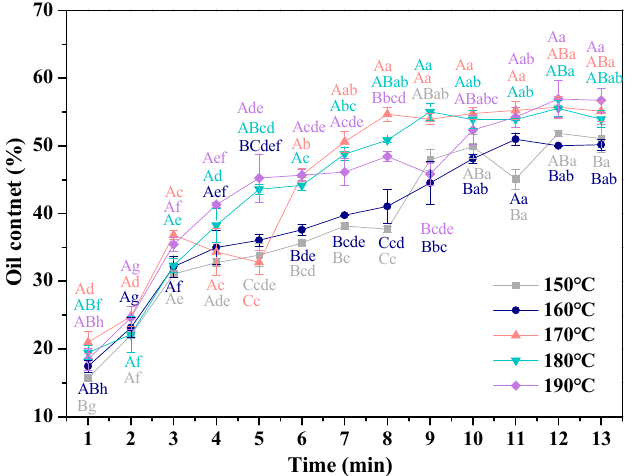
Figure 4. Effect of frying temperatures and times on the oil content in French fries. The results are the mean ± SE. Different capital letters (A – C) indicate significant differences within different temperature ( p ≤ 0.05), and different lower-case letters (a – f) indicate significant differences within different times ( p ≤ 0.05).